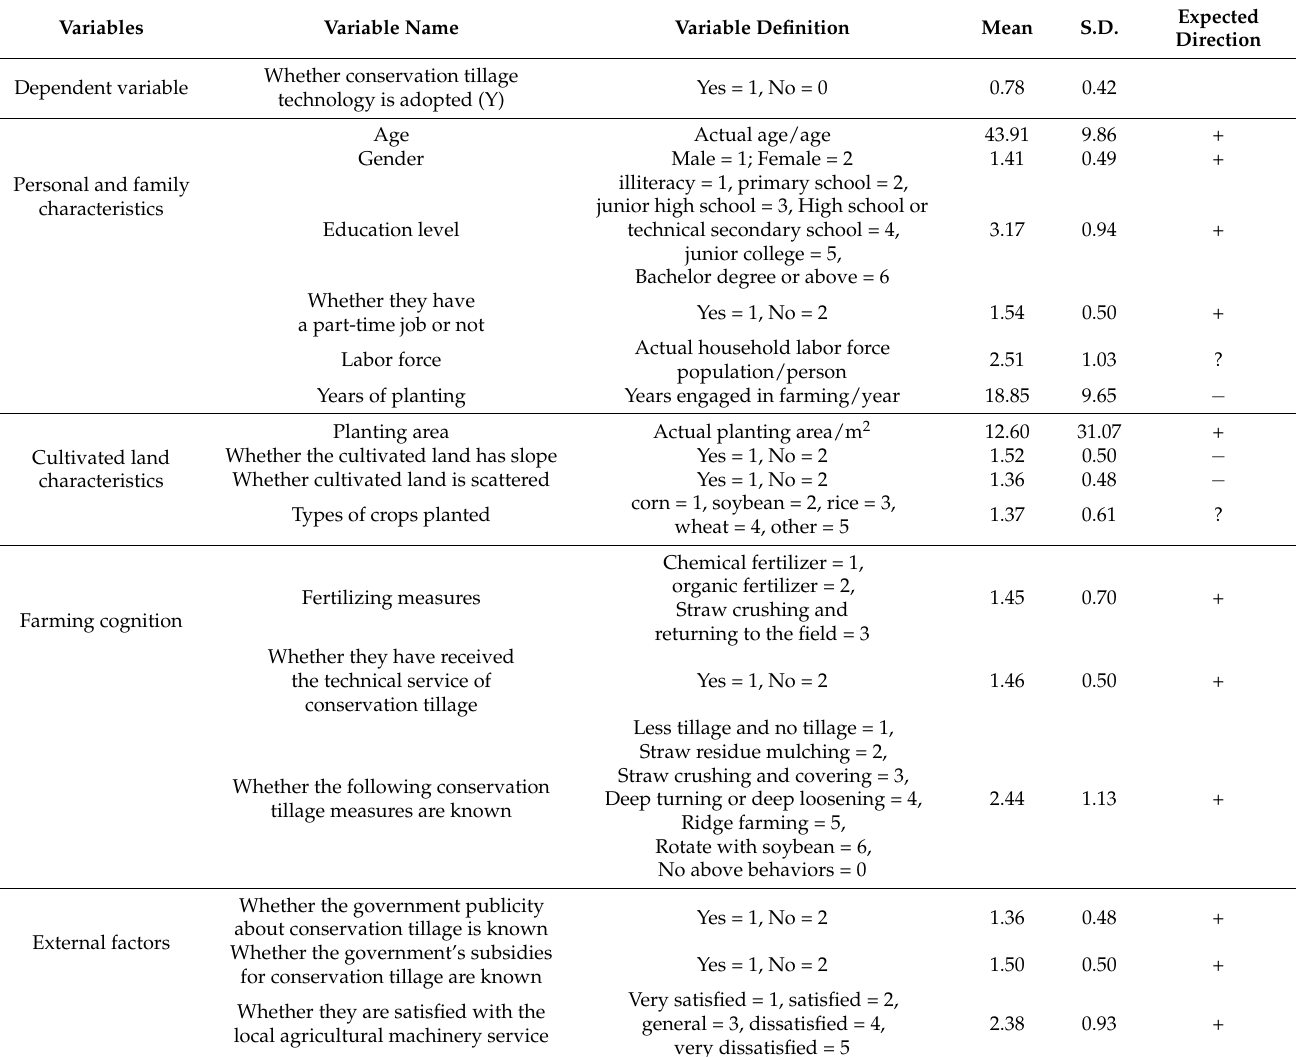
Table 1. Variable description and descriptive